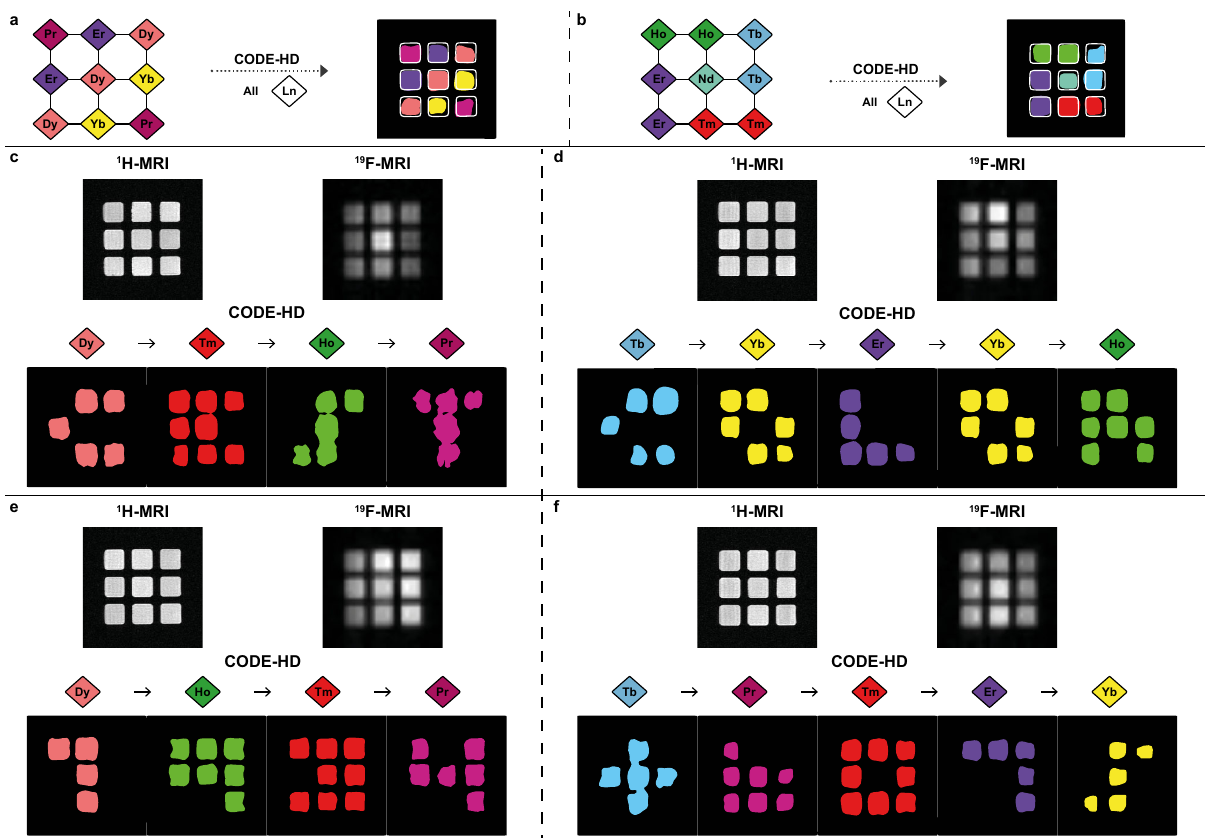
Fig. 4 Molecular steganography using COlor Display by Exploiting Host – guest Dynamics (CODE-HD) with pairs of lanthanides-cyclodextrins (Ln- CDs):2. Hidden colored barcodes ( a , b ). A given pattern in which a single Ln-CD : 2 pair was loaded in each well of the studied 3 × 3 multiwell plates (diamonds) and the resultant CODE-HD maps (squares), revealing the hidden color-code barcodes. Hidden words ( c , d ). Proton magnetic resonance imaging ( 1 H-MRI) and 19 Fluorine-MRI ( 19 F-MRI, shown in grayscale) of the studied 3 × 3 multiwell plates and sequential CODE-HD maps obtained in a given order (Dy – Tm – Ho – Pr and Tb – Yb – Er – Yb – Ho for c and d , respectively), revealing the hidden words (CEST and COLOR for c and d , respectively). Hidden PIN codes ( e , f ). 1 H-MRI and 19 F-MRI (shown in grayscale) of the studied 3 × 3 multiwell plates and sequential CODE-HD maps obtained in a given order (Dy – Ho – Tm – Pr and Tb – Pr – Tm – Er – Yb for e and f , respectively), revealing the hidden PIN codes (1934 and *6075 for e and f ,